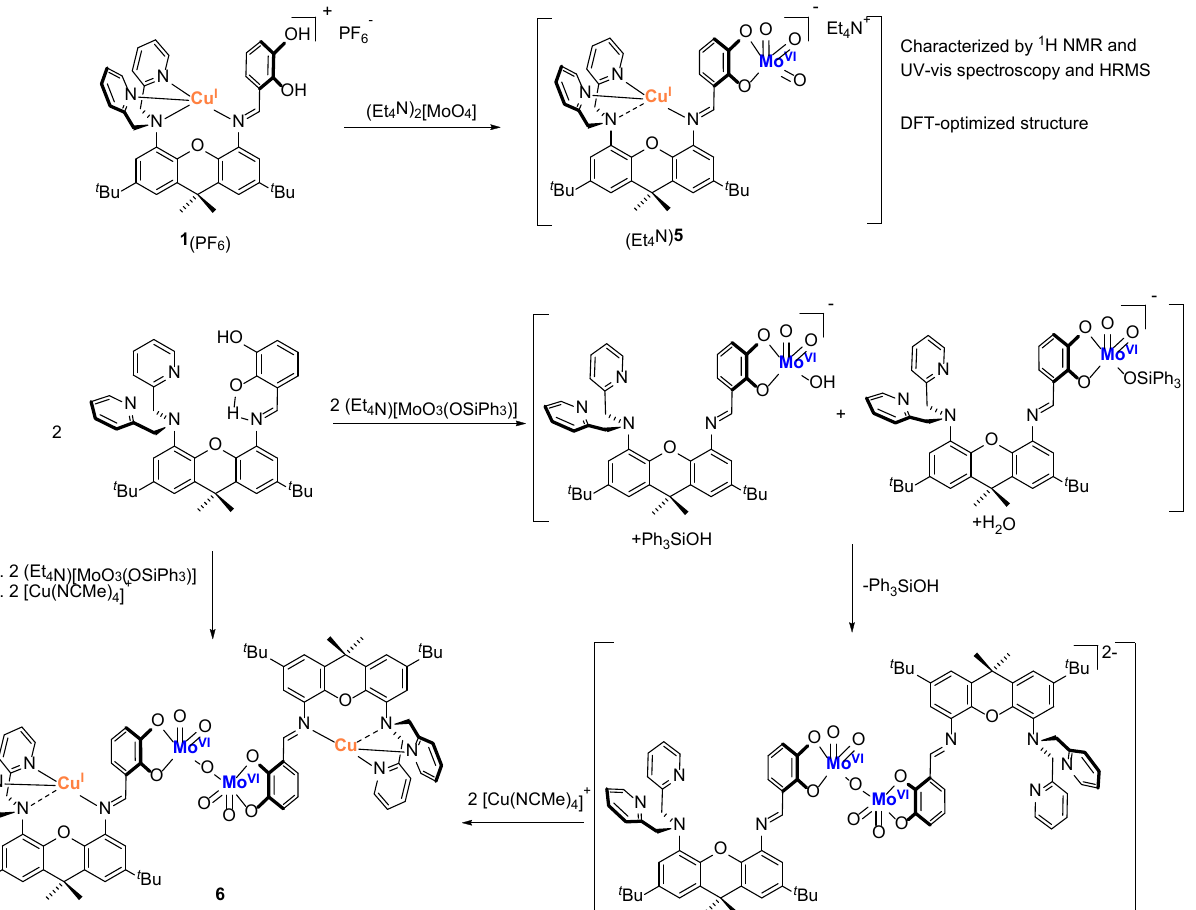
Scheme 3. Top: Previously described formation of complex (Et 4 N) 5 . Bottom: Formation of